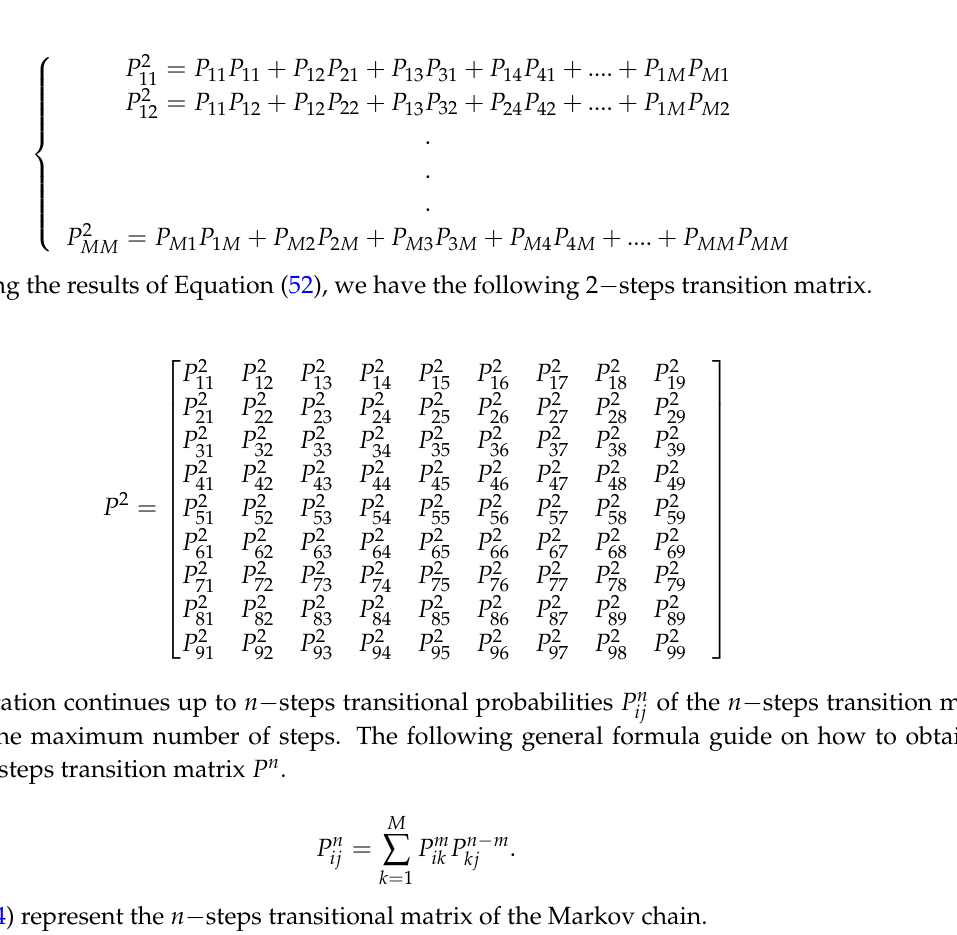
Figure 15 depict the new transition matrix A (cid:48) formed as the aggregation of state symmetries of transition matrix A